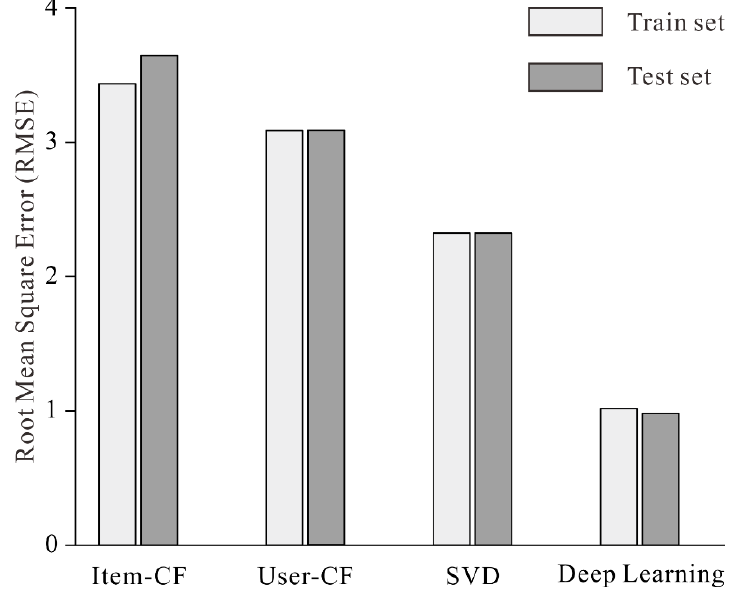
Figure 5. The RMSE scores for different algorithms based on the MovieLens 100 K dataset. Table 2. RMSE scores of the multimodal movie recommendation algorithm based on deep